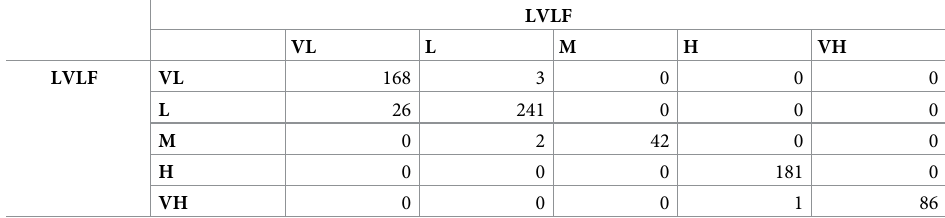
Table 3. Confusion matrix of